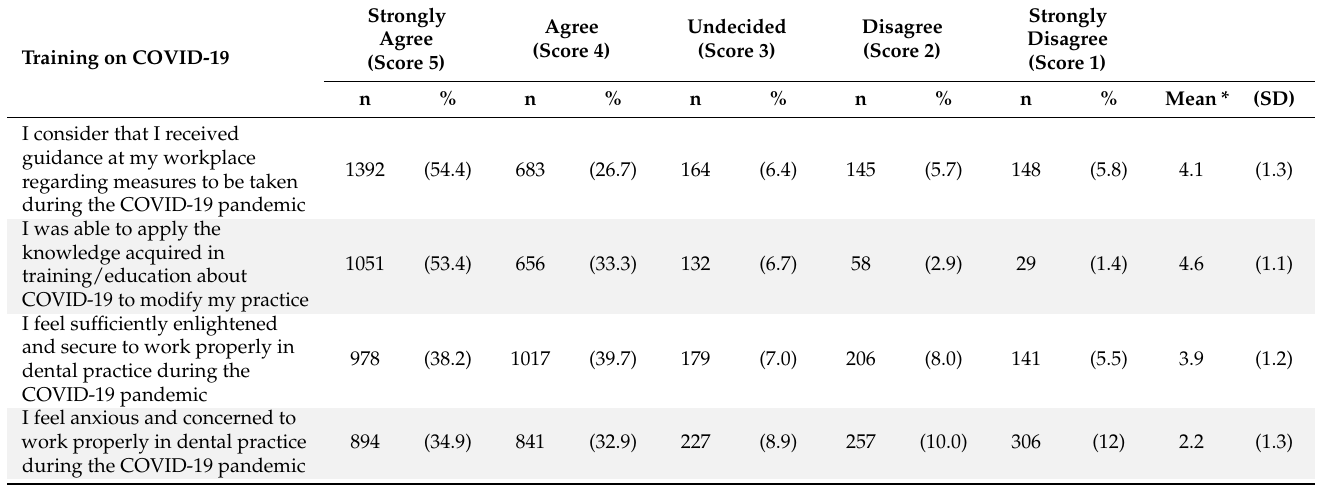
Table 5. Sample of oral health care workers’ distribution regarding training/education